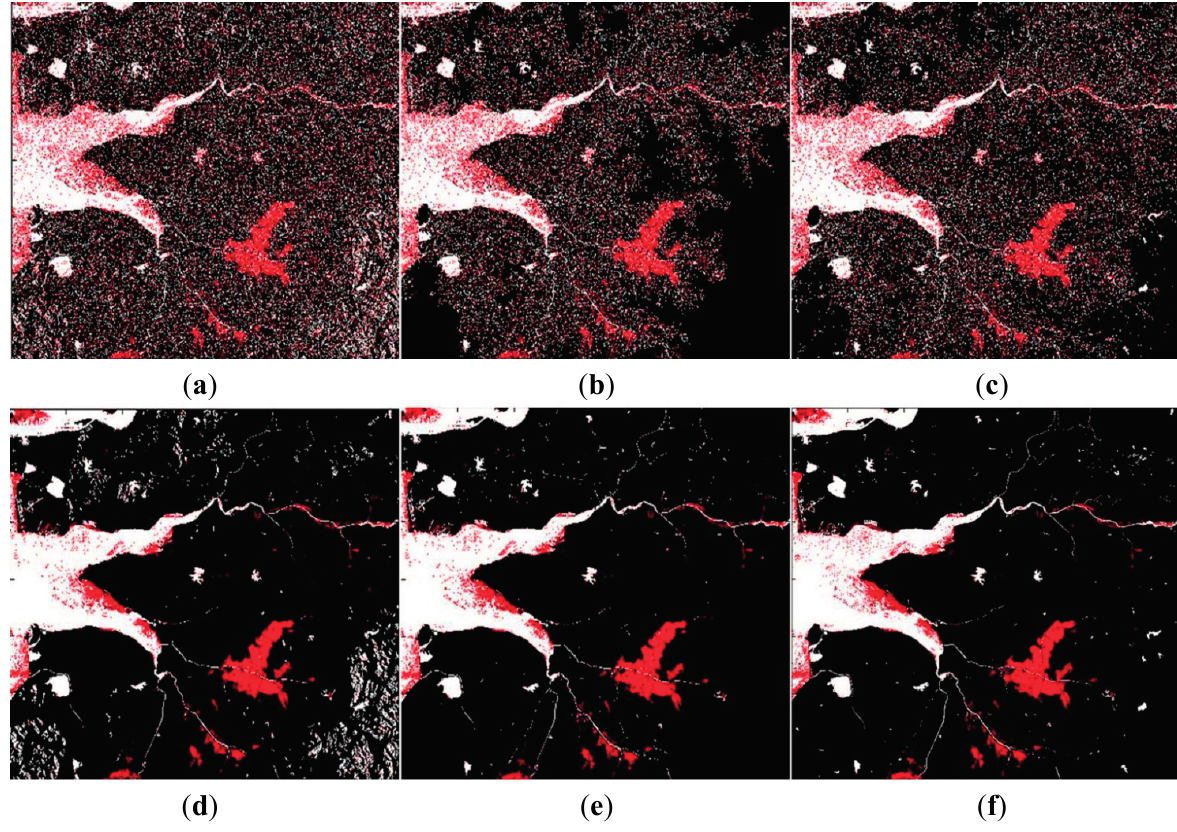
Figure 9. Flood map (red: flooded areas, white: permanent water areas): ( a ) Case #1; ( b ) Case #2; ( c ) Case #3; ( d ) Case #4; ( e ) Case #5; ( f ) Case #6.